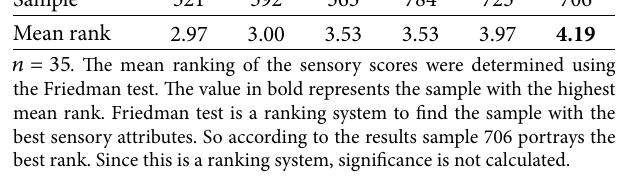
Table 7: Proximate composition of unblanched and steam blanched M. oleifera leaves dried at 65°C.